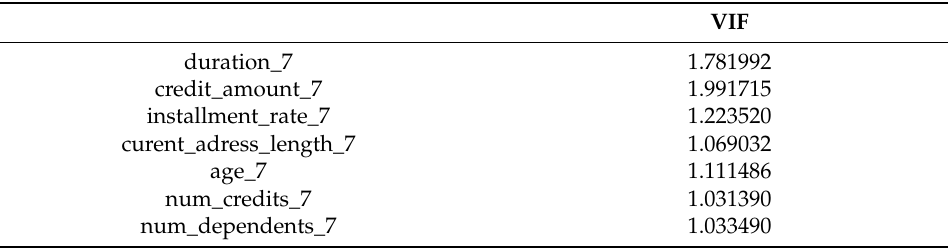
Table 10. VIF for model